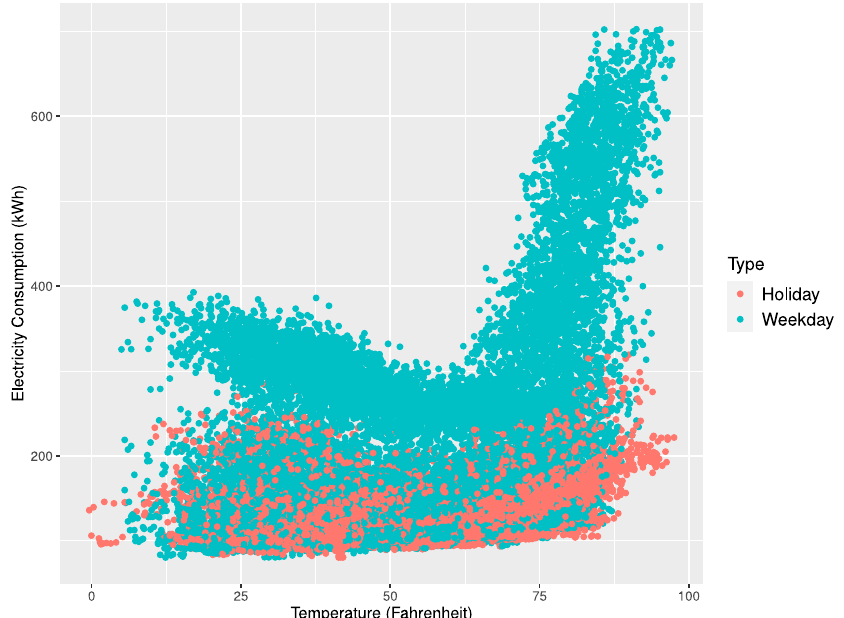
Figure 6. Scatter plot of electricity consumption and temperature for Building 3.